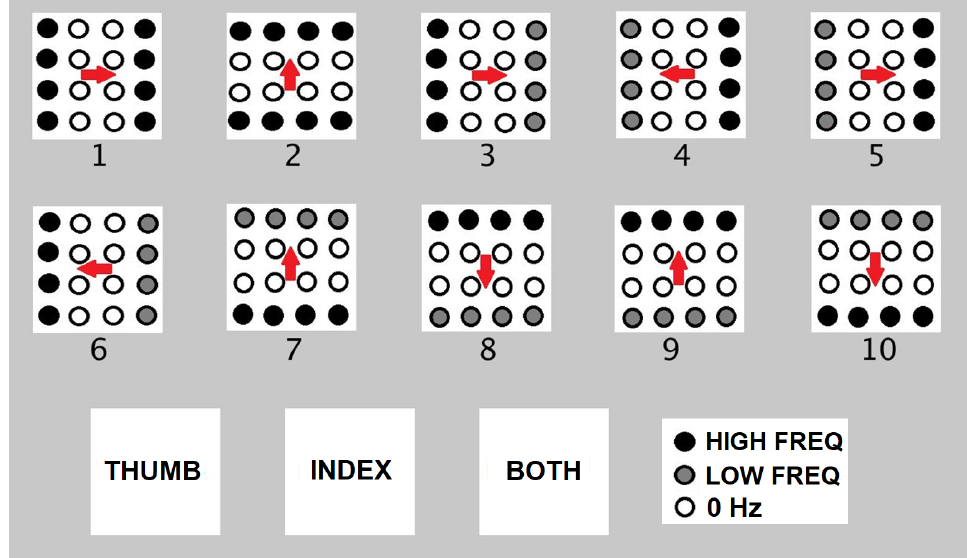
Figure 19. Patterns for temporal